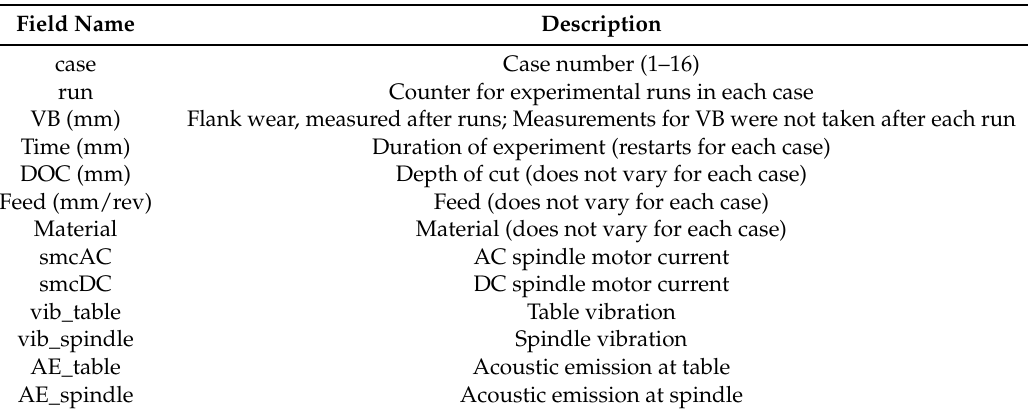
Table 1. Structure field names and description.